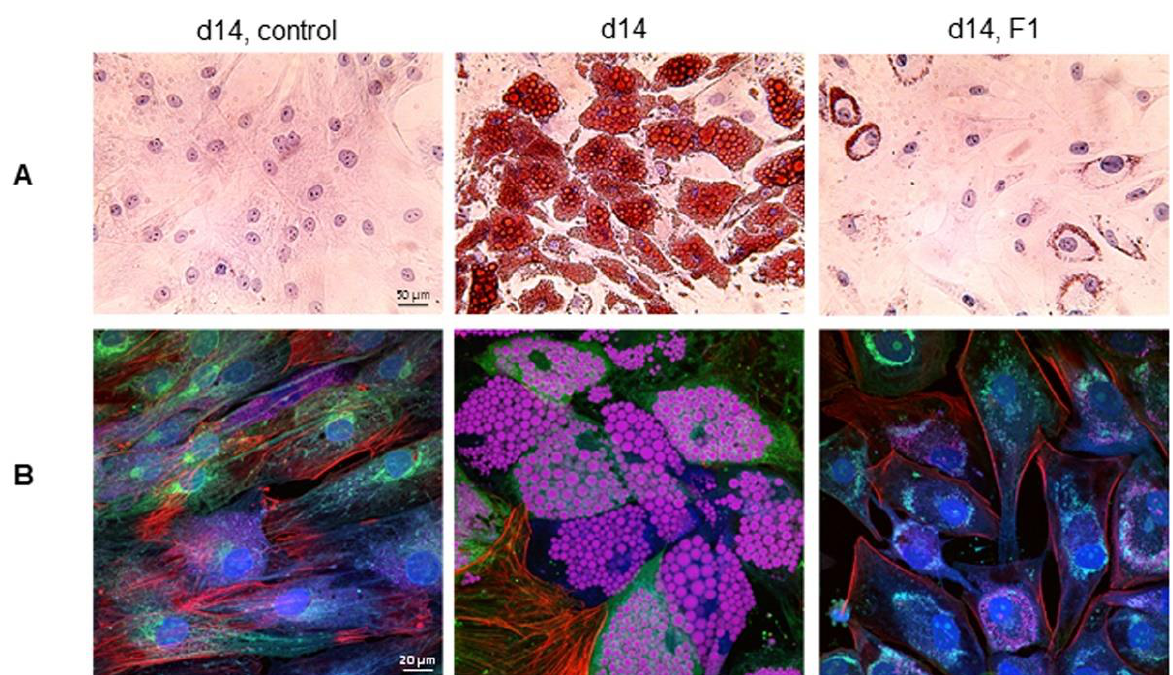
Figure 8. Inhibition of intracellular lipid droplet accumulation by the F1 composition of phytonutrients. ( A ) Brightfield images of hematoxylin-, eosin-, and Oil Red O-stained control undifferentiated preadipocytes (left panel), control differentiating adipocytes on d14 post-differentiation (middle panel), and differentiating adipocytes treated with F1 composition on d14 post-differentiation (right panel). ( B ) Multi-color confocal fluorescence images of control undifferentiated preadipocytes (left panel), control differentiating adipocytes on d14 post-differentiation (middle panel), and differentiating adipocytes treated with F1 composition on d14 post-differentiation (right panel). Cells were stained for nucleus (blue), actin (green), tubulin (red), and neutral lipids (pink).